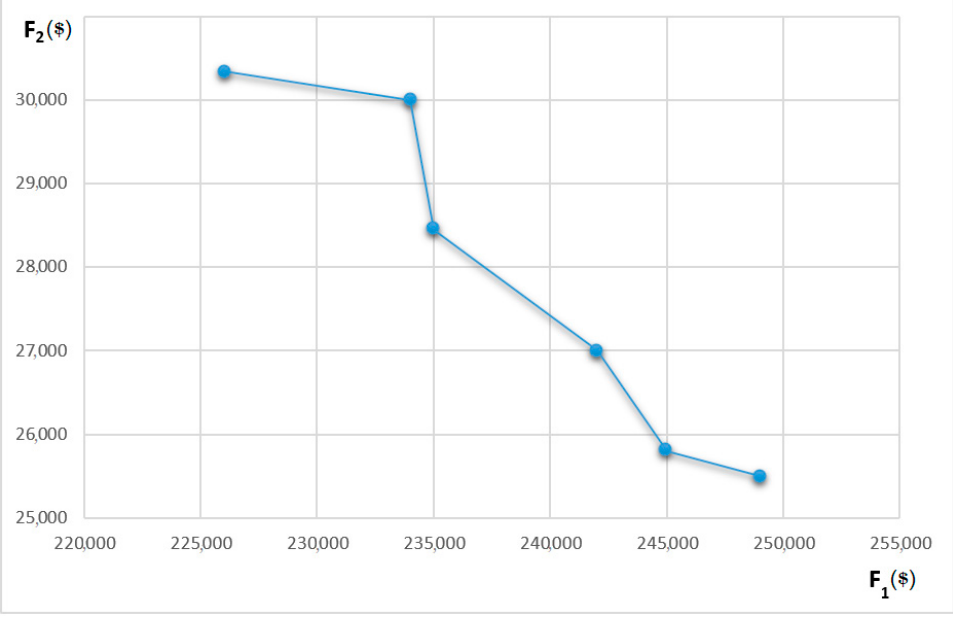
Figure 13. Best front of solutions. Table 7. Number of open gates in each charging lane for solution 2.